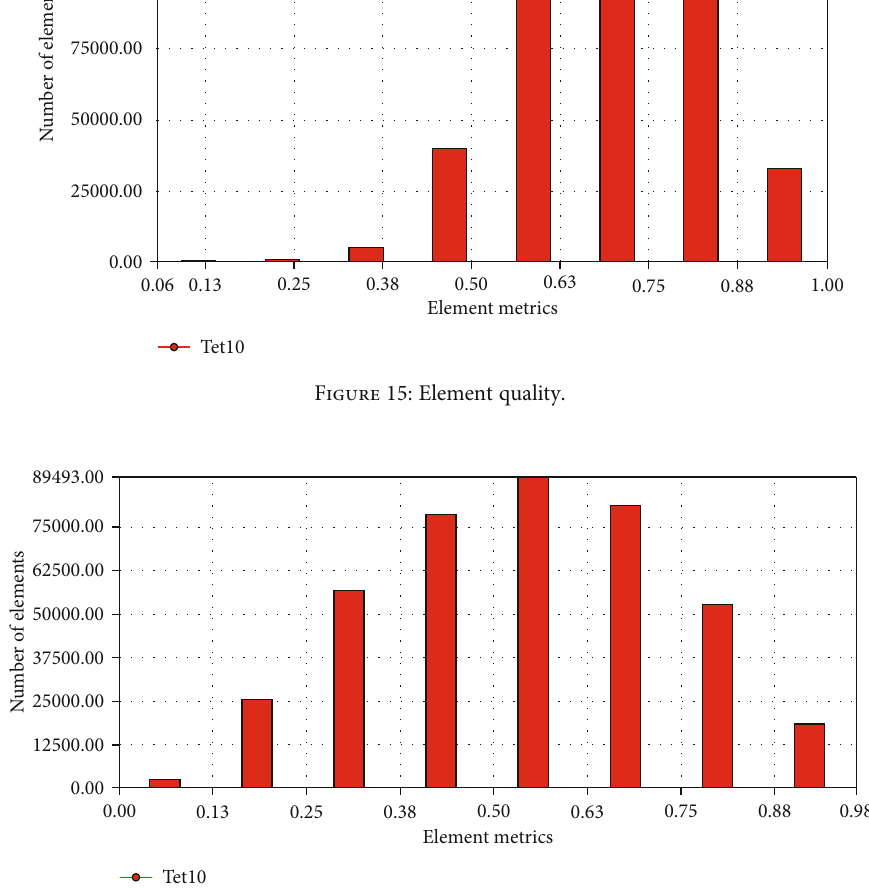
Figure 16: Orthogonal